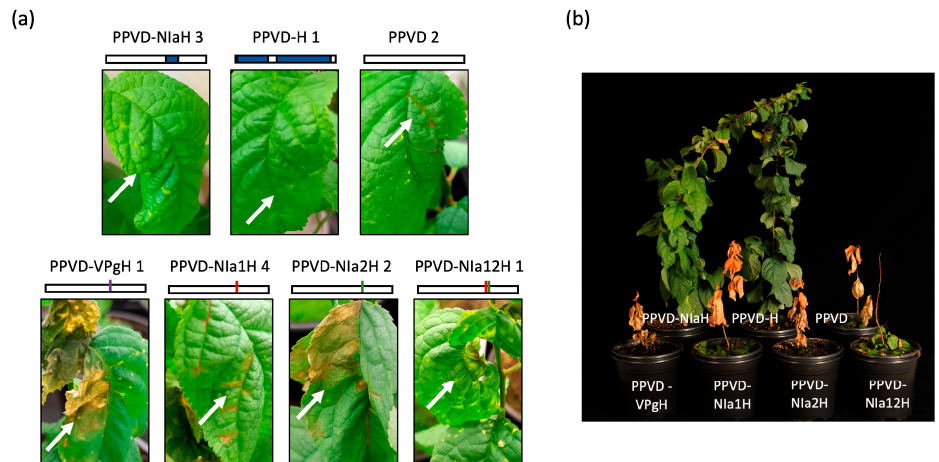
Figure 4. Testing of single and double mutants of PPVD-NIaH in ‘Dospina 235 ′ -resistant and ‘Weiwa’-susceptible plants. ( a ) Images taken at 21 dpi from leaves showing di ff erent symptoms depending on the inoculated virus; all images correspond to ‘Dospina 235 ′ plants; the number following the viral name indicates the number of the plant; small scheme of the viral constructs is depicted: PPVD and PPVD-H sequences are shown in white and in blue, respectively; mutations in VPg, NIa1H and NIa2H are shown in purple, red and green, respectively; white arrows mark the observed symptoms. ( b ) Image of full plants taken at 134 dpi.